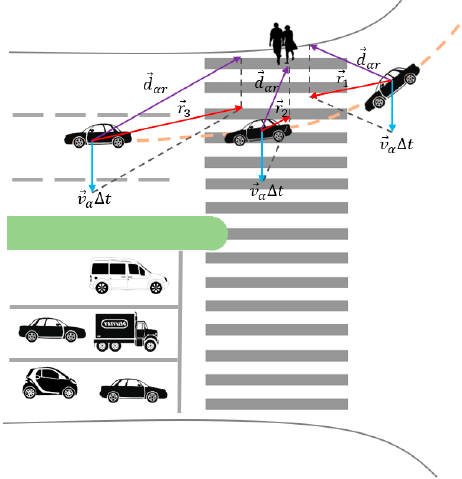
Figure 6. Repulsive force exerted by a vehicle at different positions on a pedestrian.